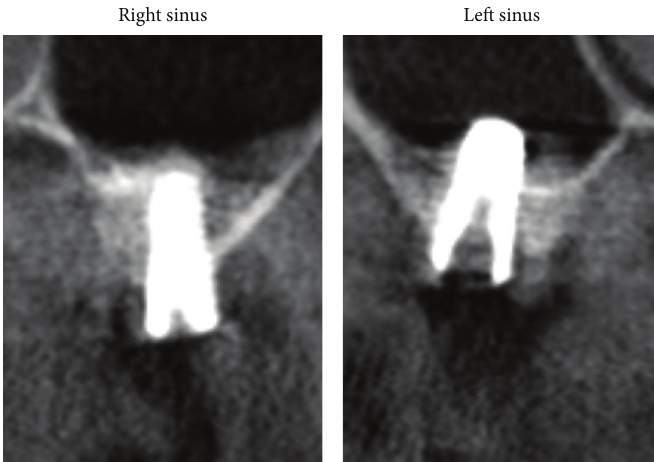
Figure 2: CBCT exam at 5 years. Note the absence of Schneiderian membrane thickening on the coronal view of implant placed with grafting material (right sinus, second molar site) and without grafting material (left sinus, second molar site). The CBCT confirms that the implant in the left sinus protruded into the sinus whereas the implant in the right sinus was completely embedded in peri-implant